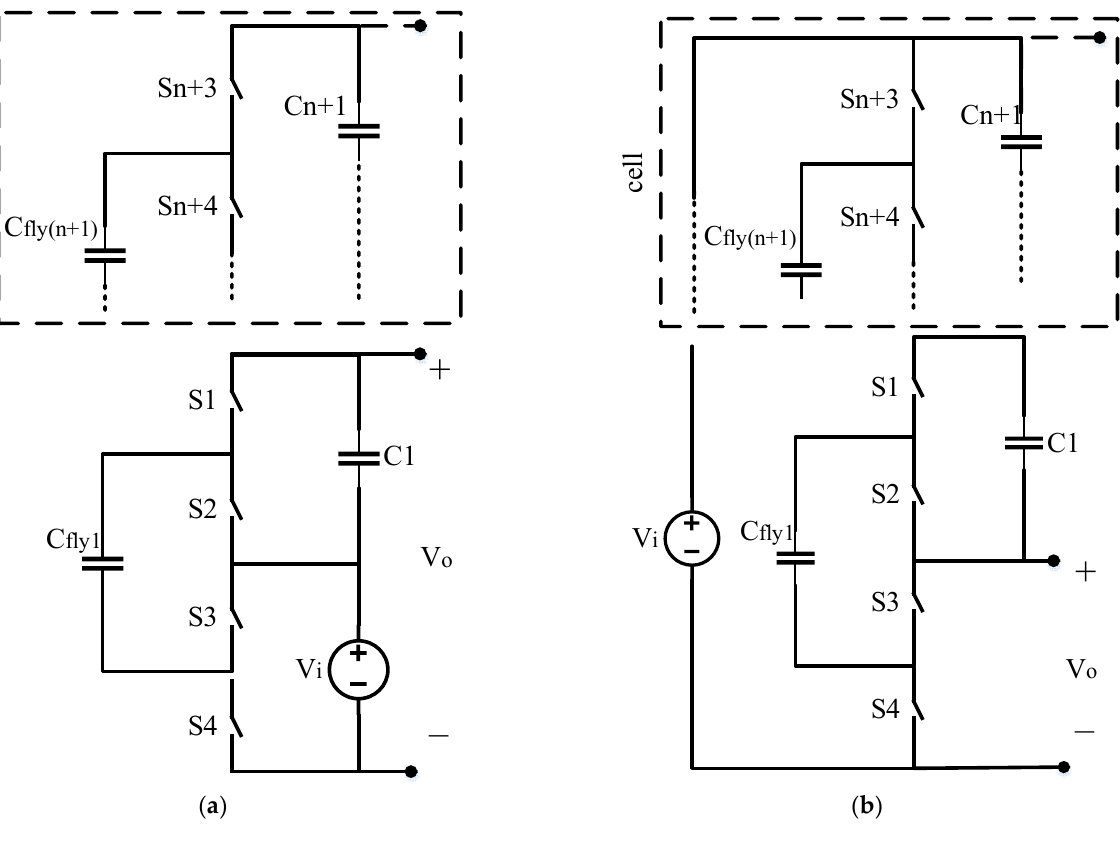
Figure 8. ( a ) Boost and ( b ) buck ladder cells.